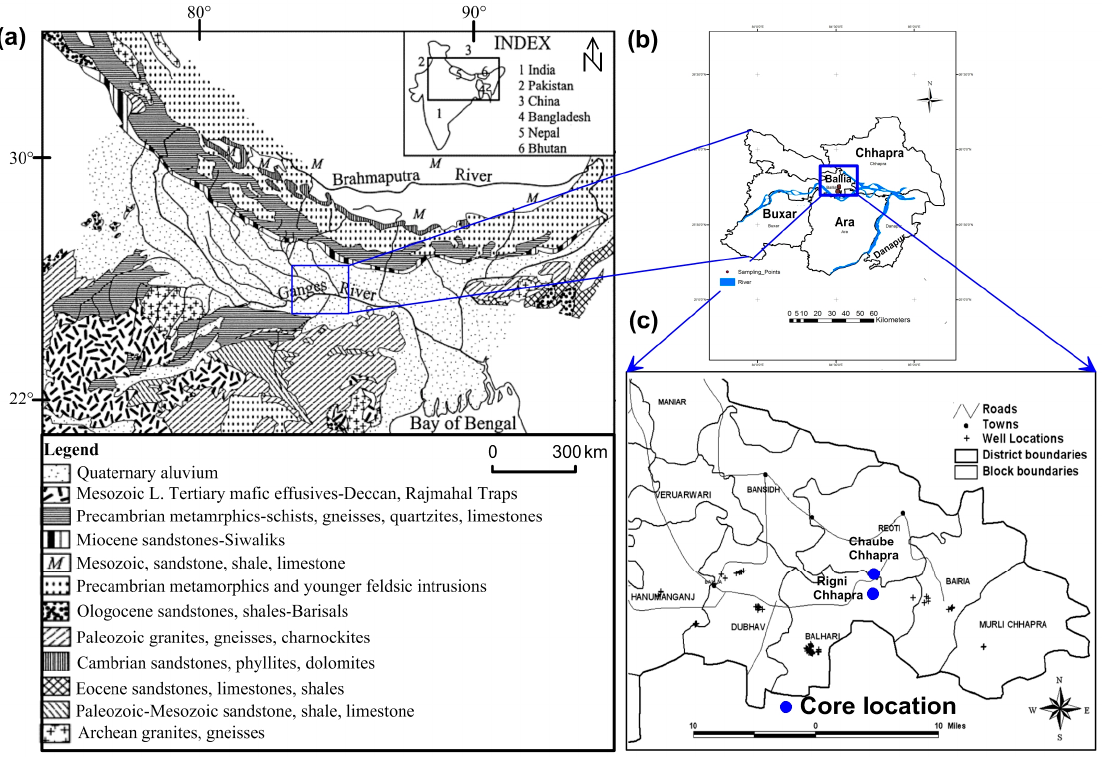
Figure 1. Study area map ( a ) Geological map of the Ganges and Brahmaputra drainage basins (modified from [28]; ( b ) surrounding area near the study location ( c ) Ballia district (study area) marked with core locations (modified from [25]).